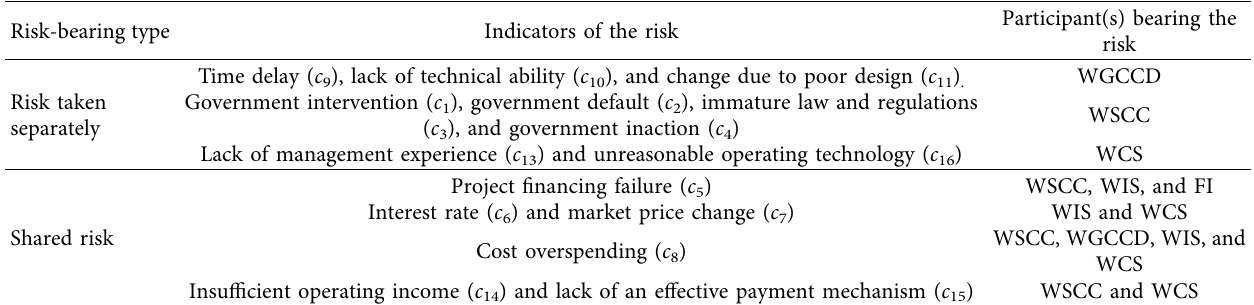
Table 6: Initial risk sharing